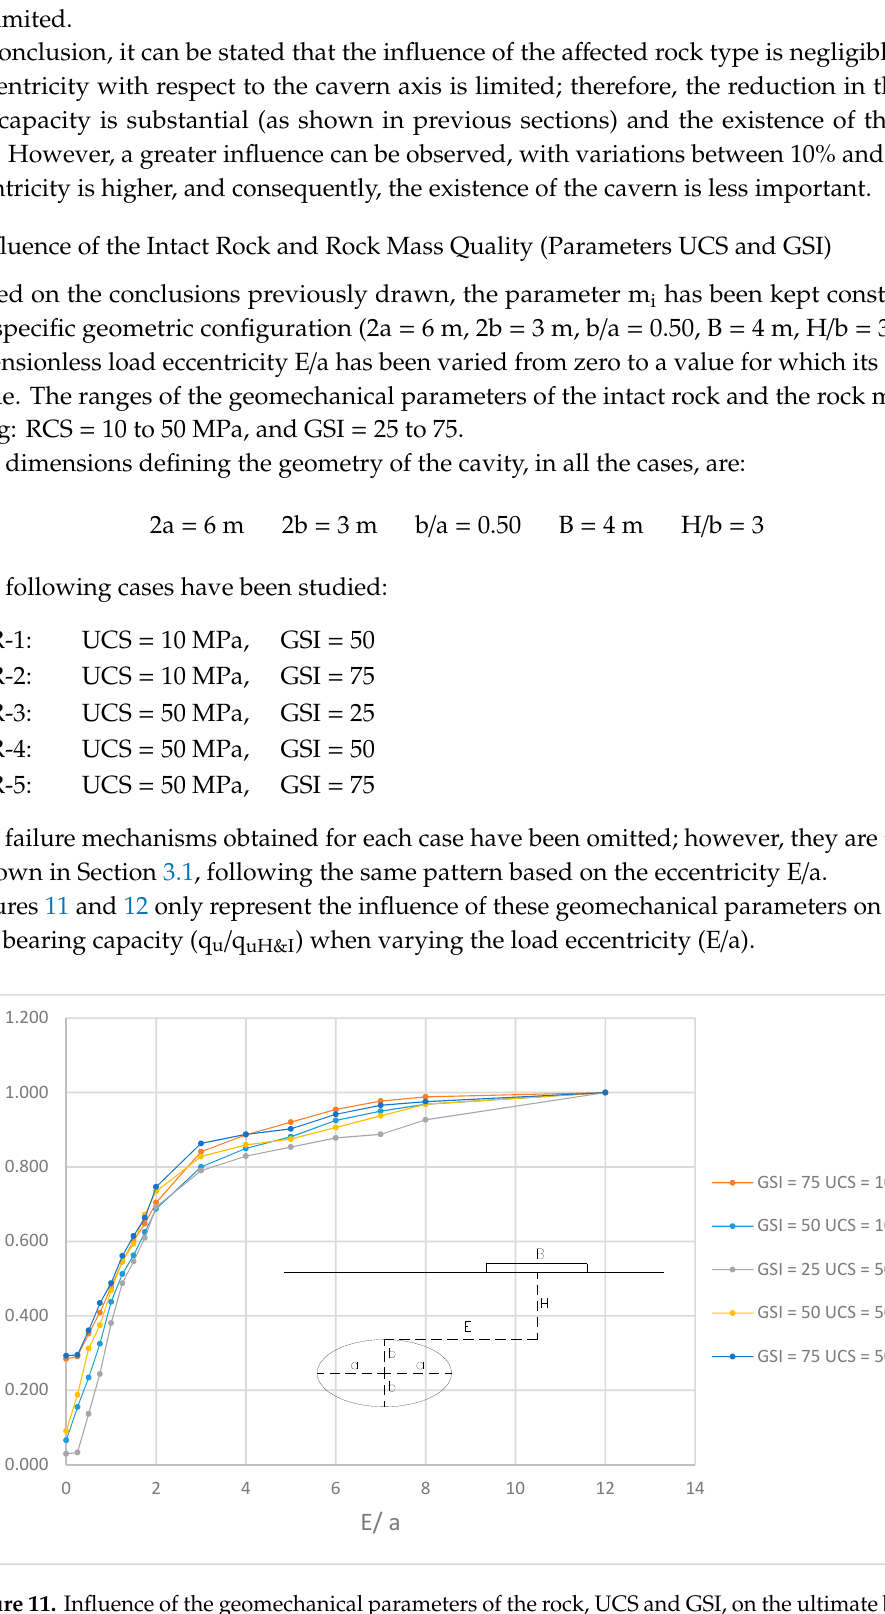
Figure 12. Influence of the geomechanical parameters of the rock, UCS and GSI, on the ultimate bearing capacity value when varying the load eccentricity. Detail between E/a = 0 and E/a = 2.